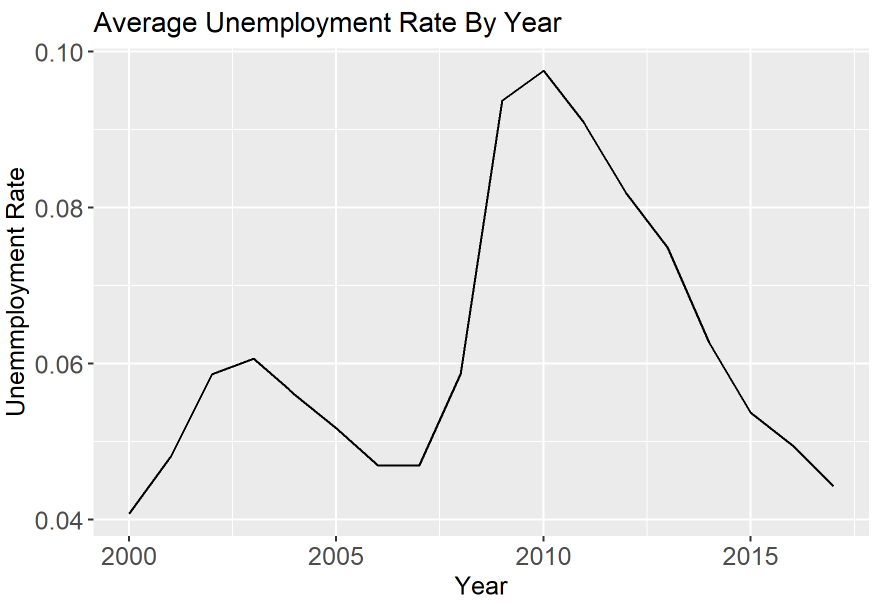
Figure 5. Average county unemployment rate weighted by county population in the years